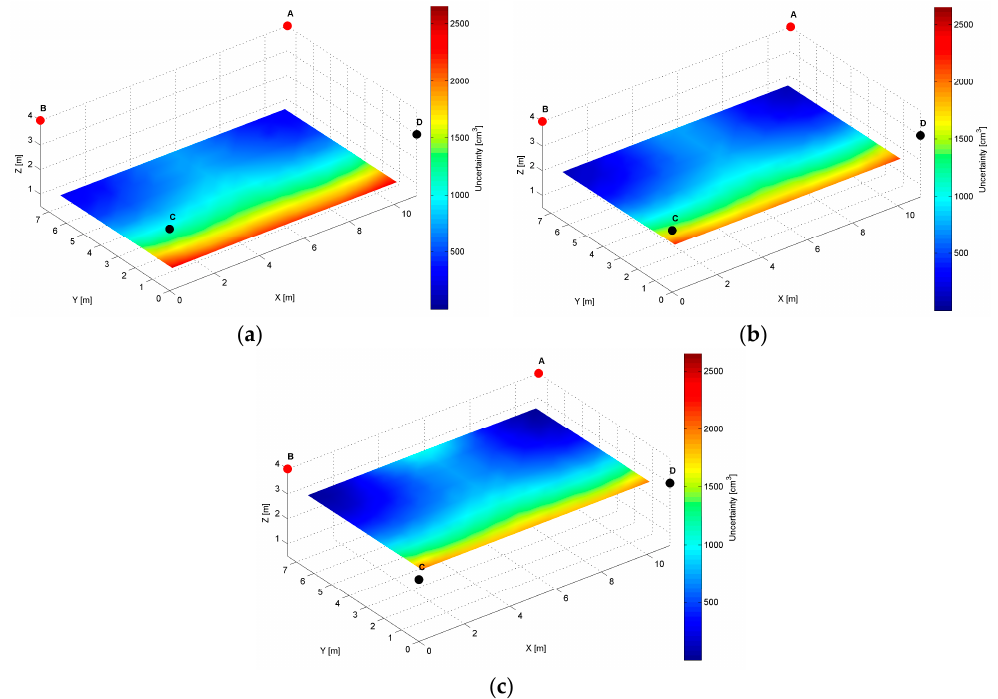
Figure 14. Cross-section ( XY plane) plots of uncertainty-precision distribution for location sensors A and B at ( a ) z = 1.00 m; ( b ) z = 2.00 m; ( c ) z = 3.00 m.